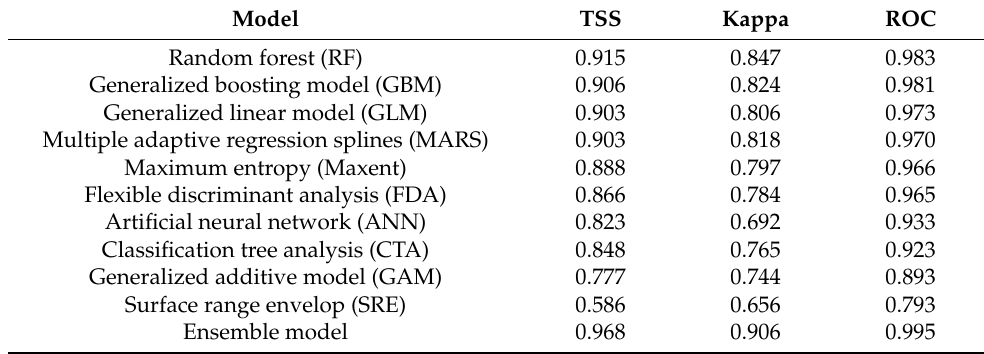
Table 2. Evaluation statistics for each modelling algorithm and the ensemble